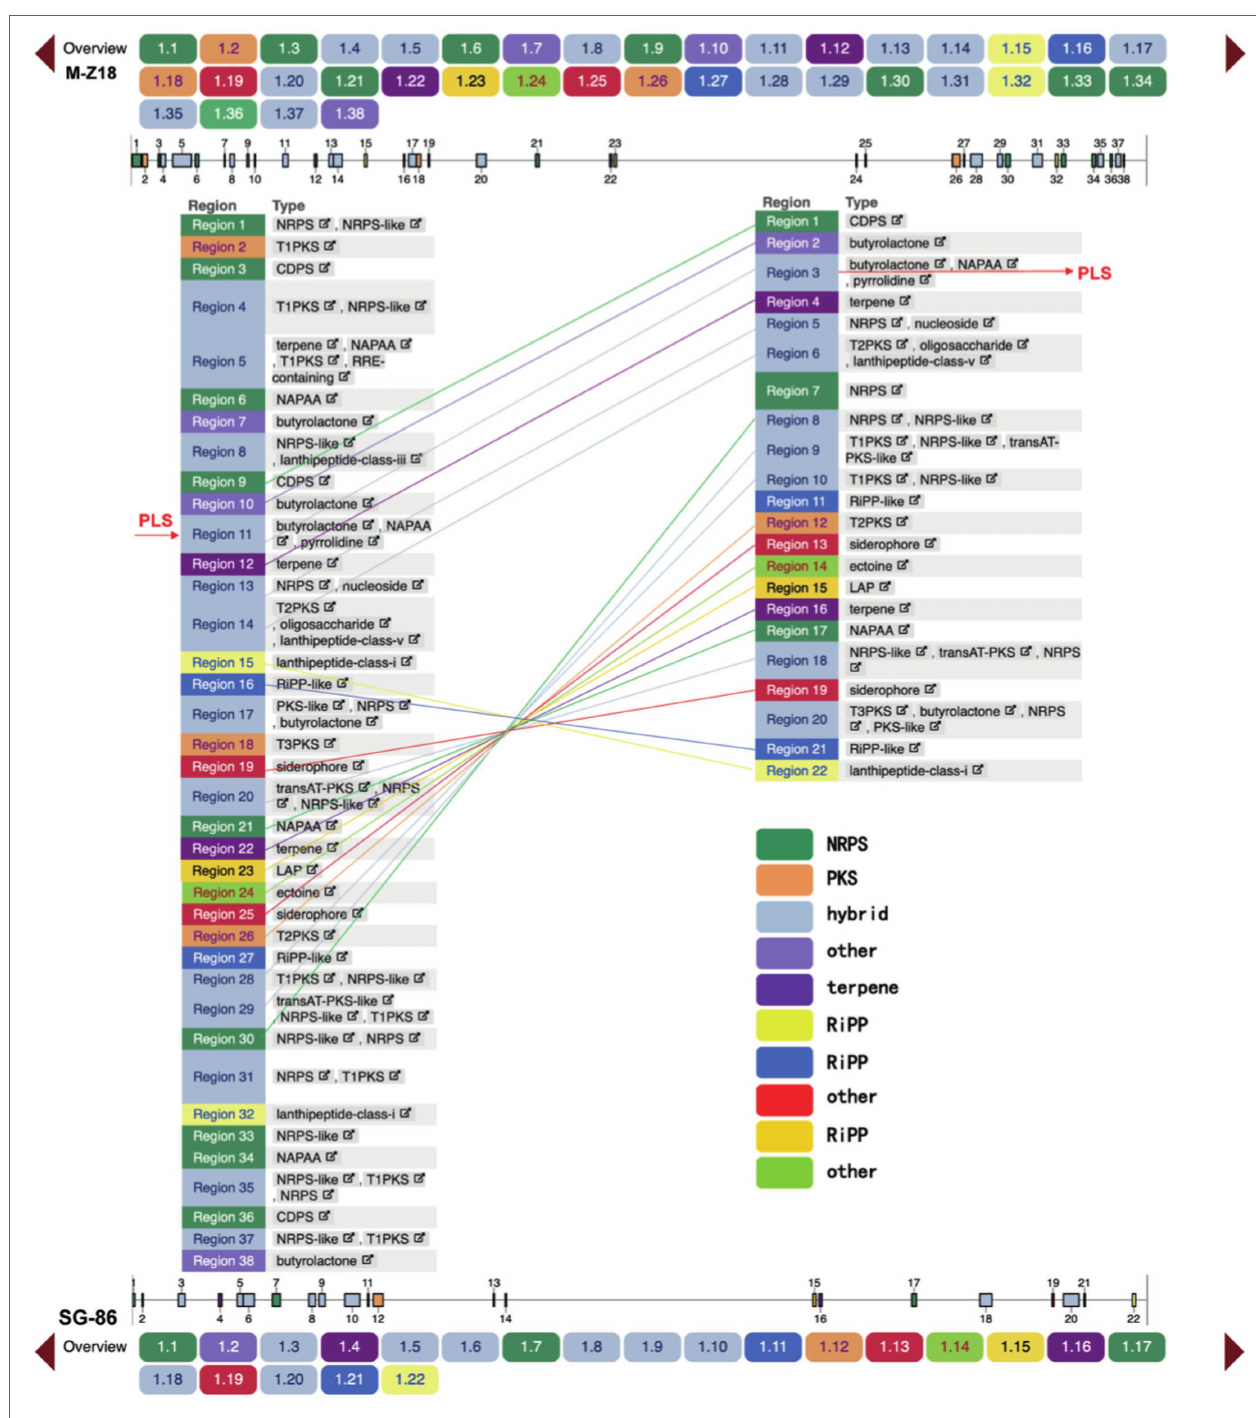
FIGURE 5 | Secondary metabolic gene clusters analysis of M-Z18 and